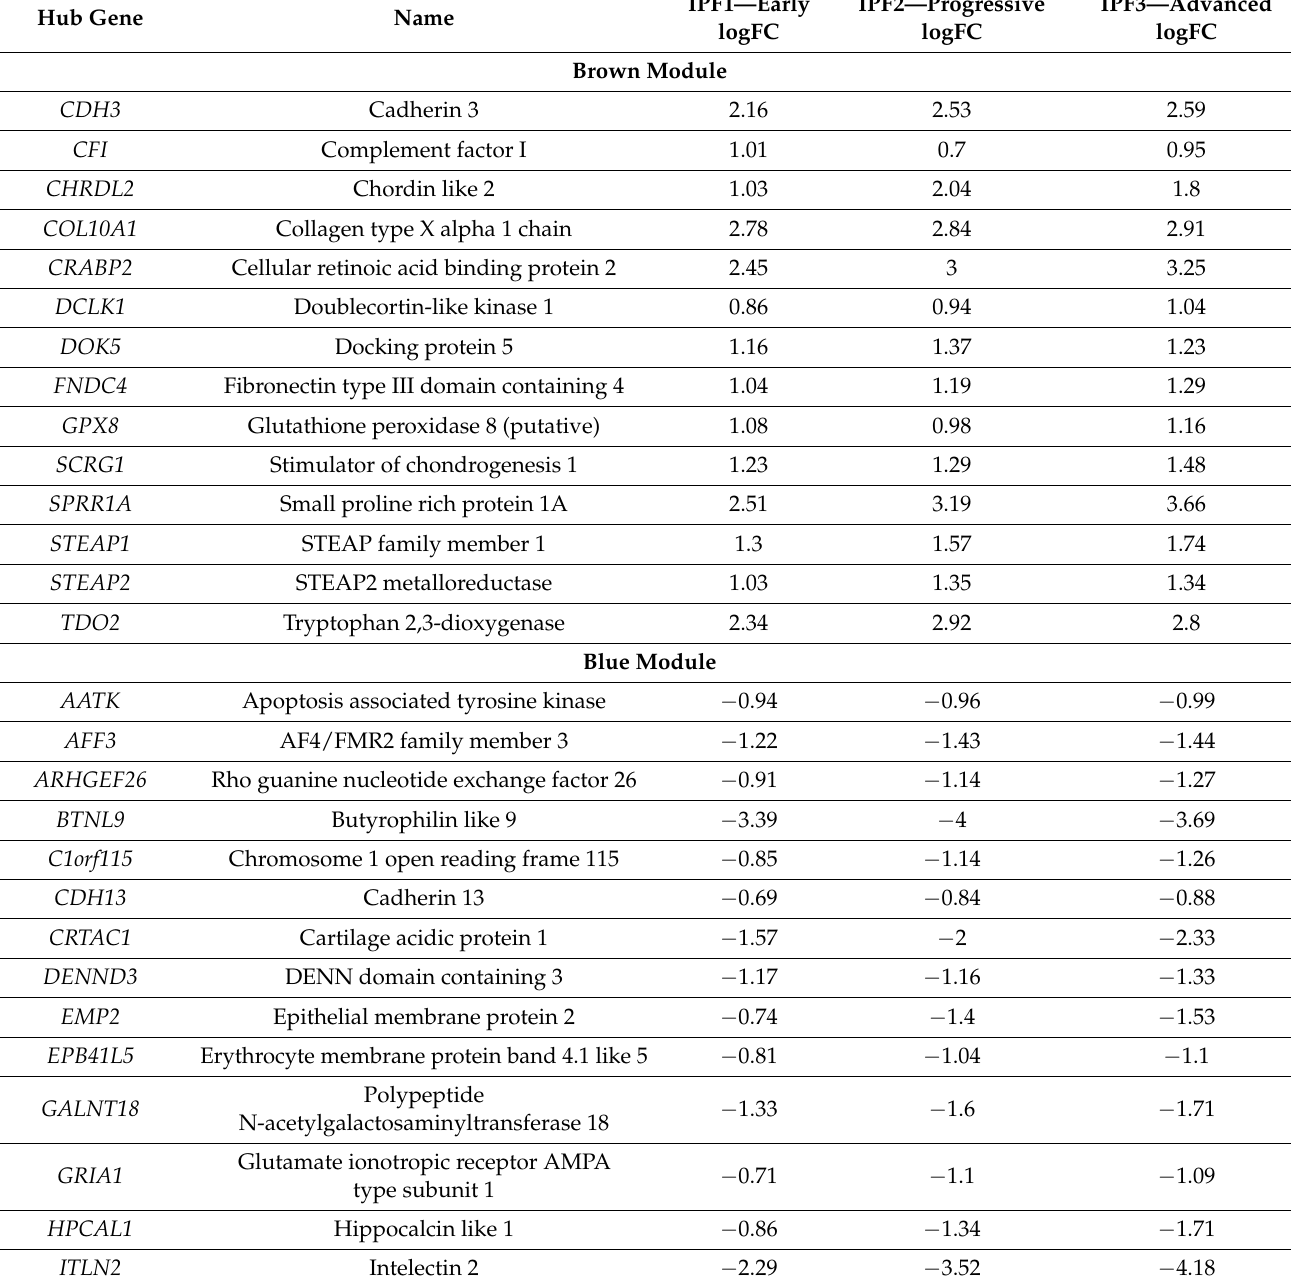
Table 2. Novel intramodular hubs which are differentially expressed across different IPF stages (GSE124685 [25]). Estimates of log2 fold changes ( ≥ 0.6 log FC or ≤− 0.6 log FC; adjusted p -value < 0.05) in each stage are listed for each candidate gene (see Supplementary Table S7 for additional